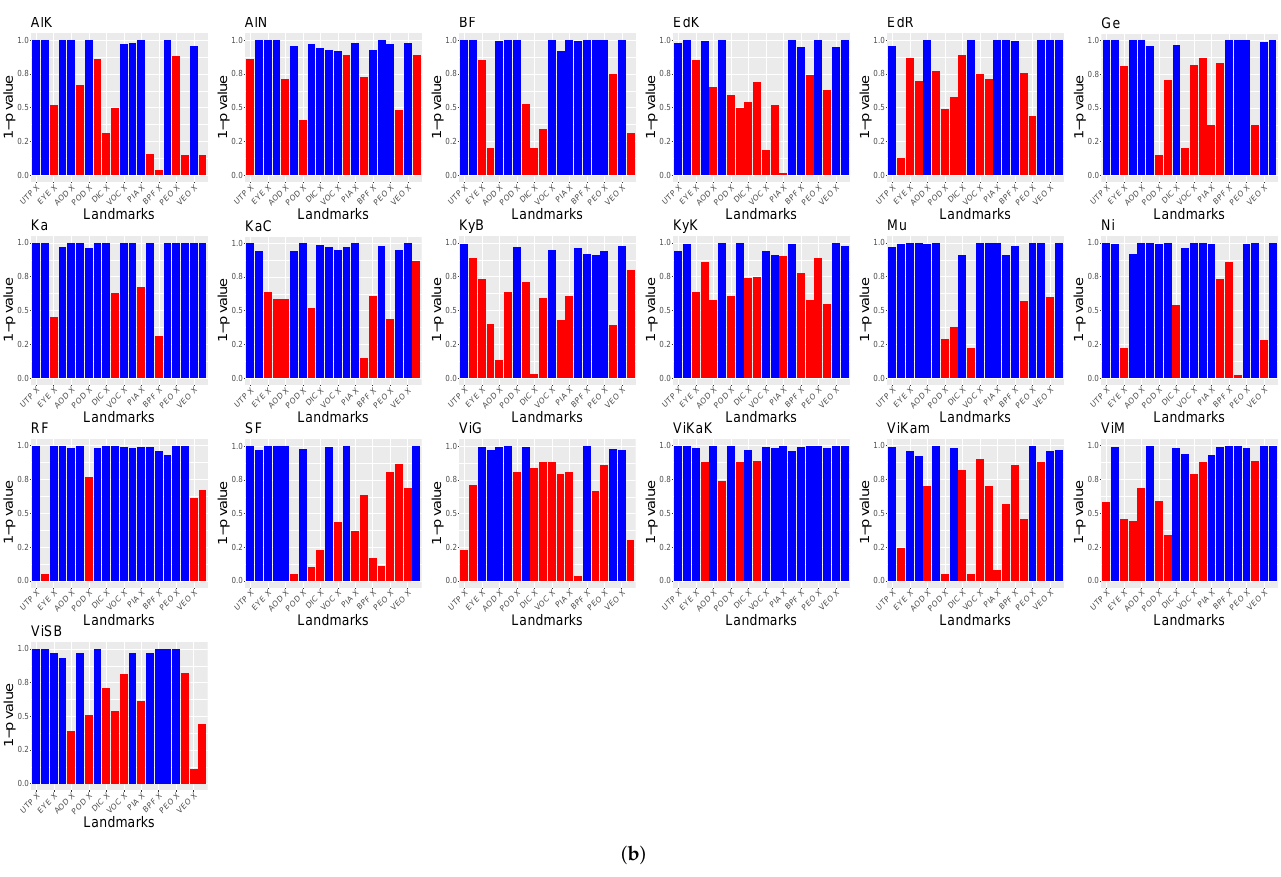
Figure 7. Visualization of Spearman’s rank correlation test for the relation between GPA coordinates and the specimens population. 1 − p is shown instead of the p -value. A p -value below α = 0.1 indicates a significant correlation of the GPA landmarks coordinate to the population. GPA coordi- nates with a p -value above α = 0.1 are shown as red bars. ( a ) Result of Spearman’s rank correlation test for the relation between the GPA coordinate and population locations in Ethiopia. ( b ) Result of Spearman’s rank correlation test for the relation between the GPA coordinate and population locations in